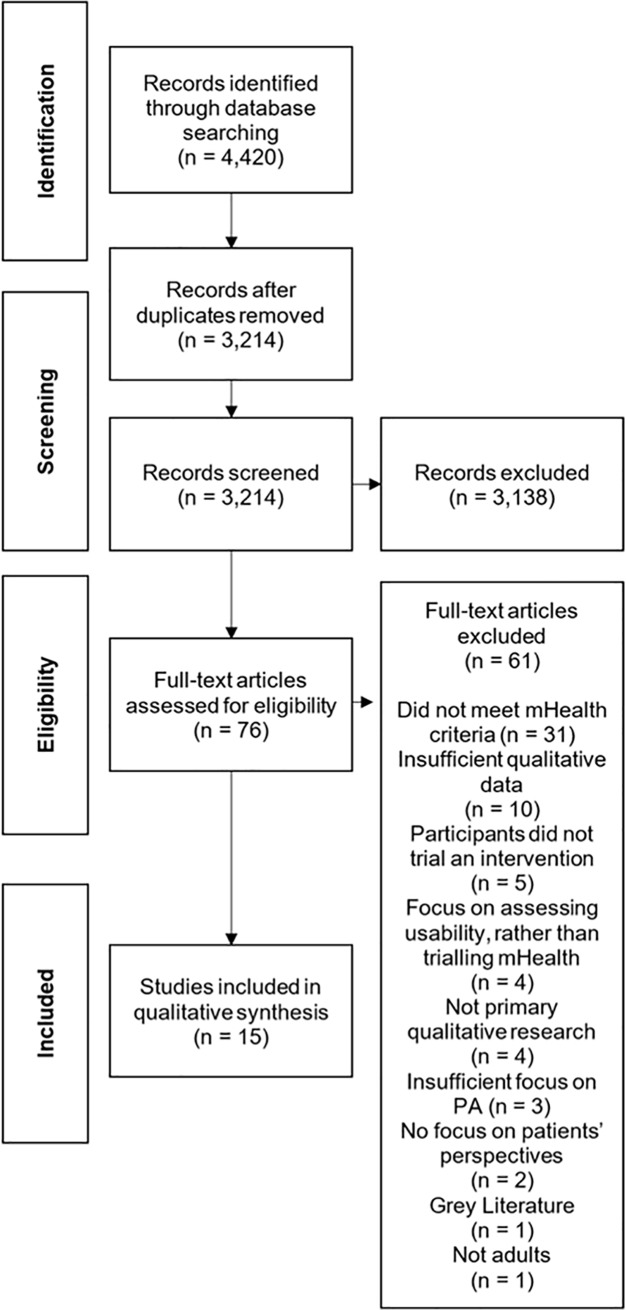
PRISMA flow diagram.